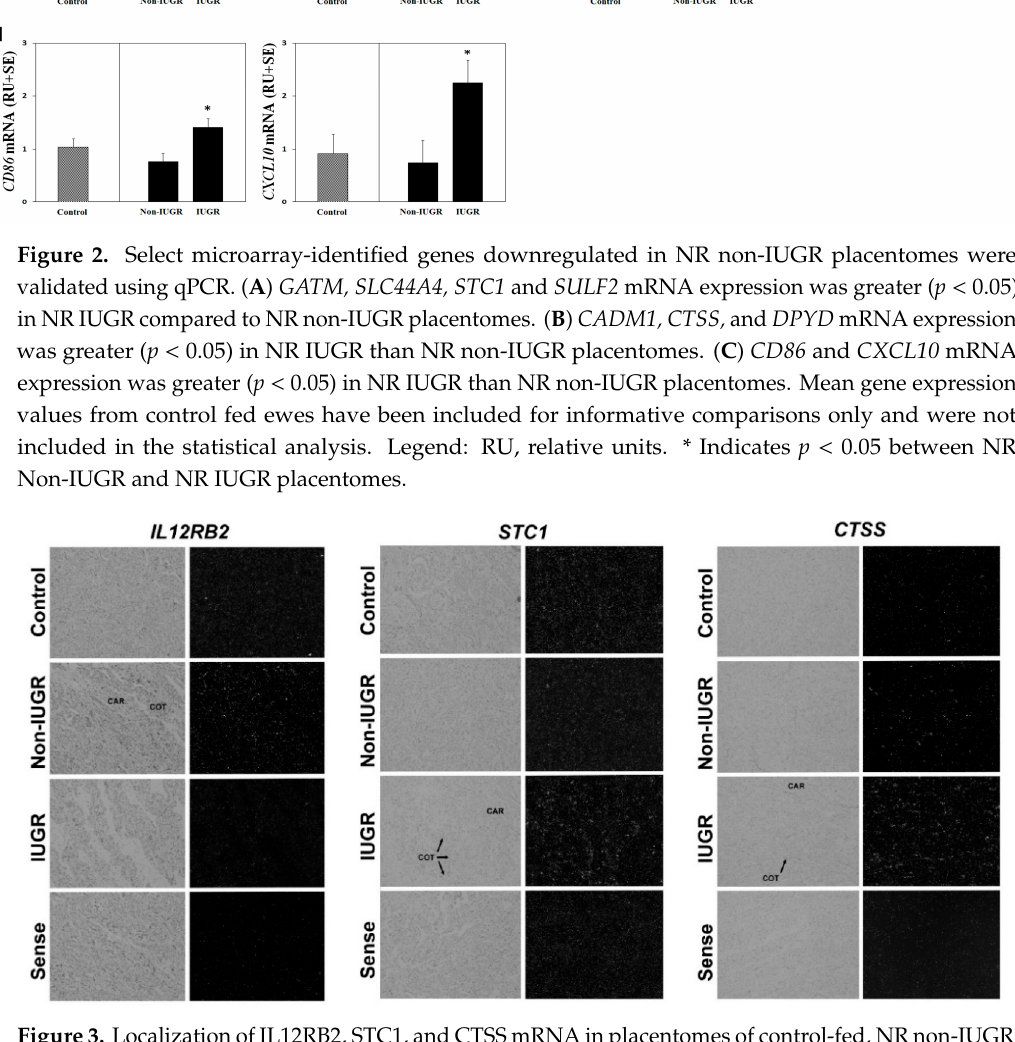
Figure 3. Localization of IL12RB2, STC1, and CTSS mRNA in placentomes of control-fed, NR non-IUGR, and NR IUGR pregnancies. Expression of IL12RB2 mRNA was weak in the placentomes of control or NR IUGR pregnancies. Expression of IL12RB2 mRNA was detected in scattered cells throughout the carunclular stroma of NR non-IUGR placentomes. The relative abundance of STC1 and CTSS mRNAs was greater in the cotyledonary tissue of NR IUGR placentomes as compared to NR non-IUGR or controls. Expression of STC1 mRNA was detected in a diffuse pattern throughout the cotyledonary tissue, while CTSS appeared to be more abundant at the fetal-maternal interface of the cotyledon and caruncle. CAR denotes caruncle and COT denotes cotyledon. All photomicrographs are shown at the same width of field (420 µm). Table 3. Functional annotation clusters of biological terms representing upregulated genes in NR non- IUGR compared to NR IUGR placentomes.